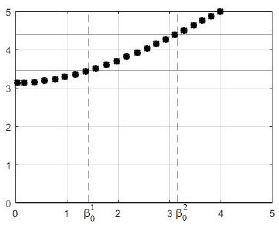
Figure 7. Grapfics of the function f ( β,ξ ) for ξ = 0 . 1 and ξ = 0 . 6. h = 0 . 02; γ = 3 . 44. If ξ 2 > ξ 1 , then β 2